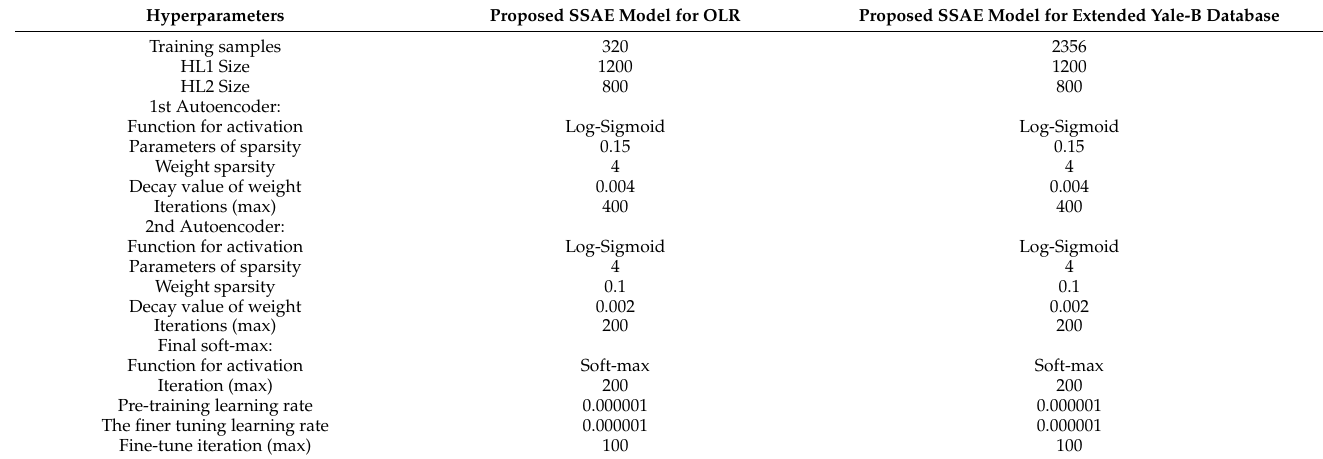
Table 2. Training hyperparameters for proposed SSAE deep neural network.